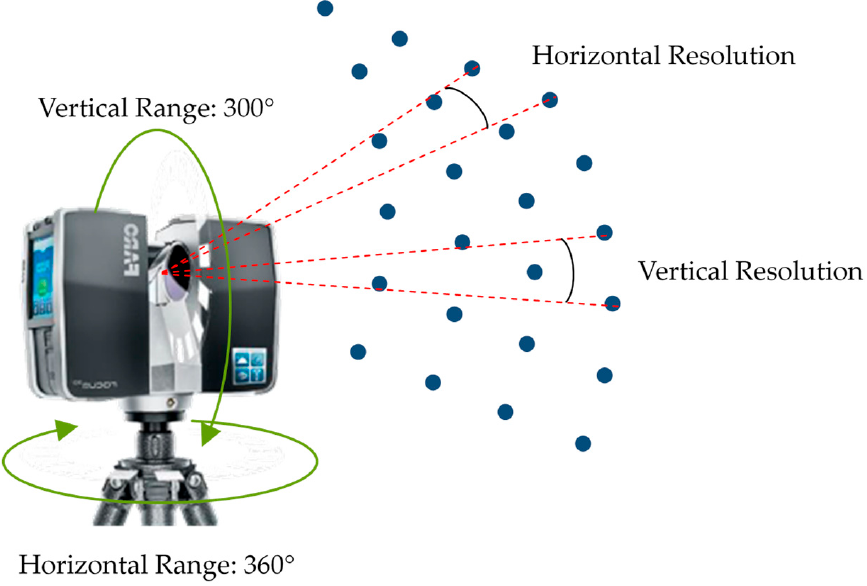
Figure 1. Principals of Operations of LiDAR.